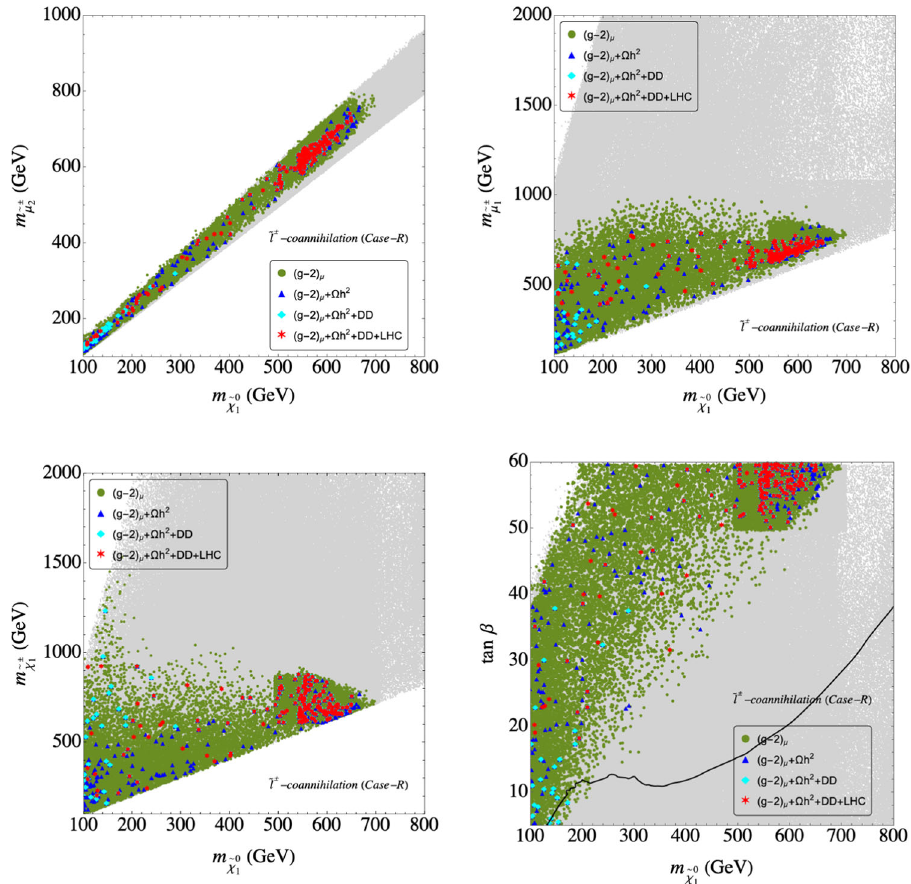
Fig. 3 Results in the ˜ l ± -coannihilation Case-R. m ˜ χ 0 – m ˜ plane (upper left), l 2 1 m ˜ χ 0 – m ˜ plane (upper right), l 1 1 m plot); for the color coding: see